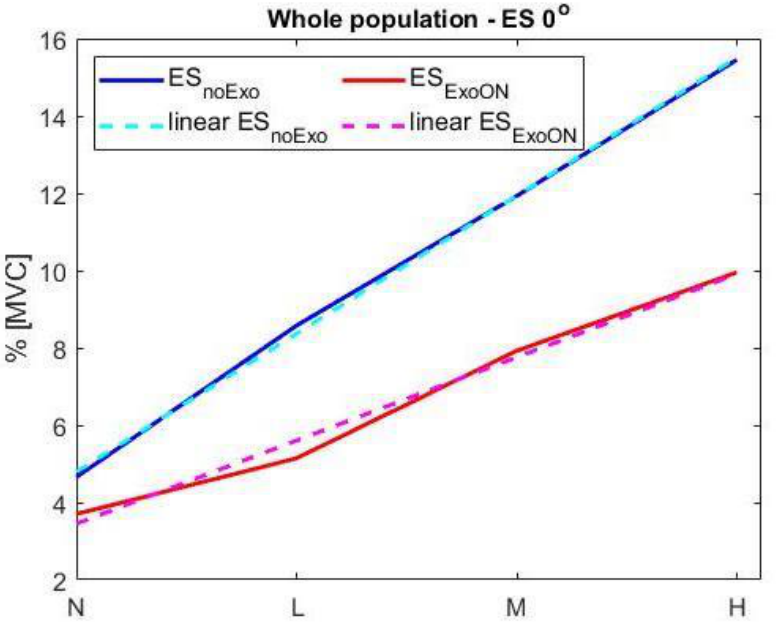
Figure 5. Interpolation trend of 90th percentile of both ES muscular activation, with and without the exoskeleton, at 0 ◦ inclination for the four load conditions.